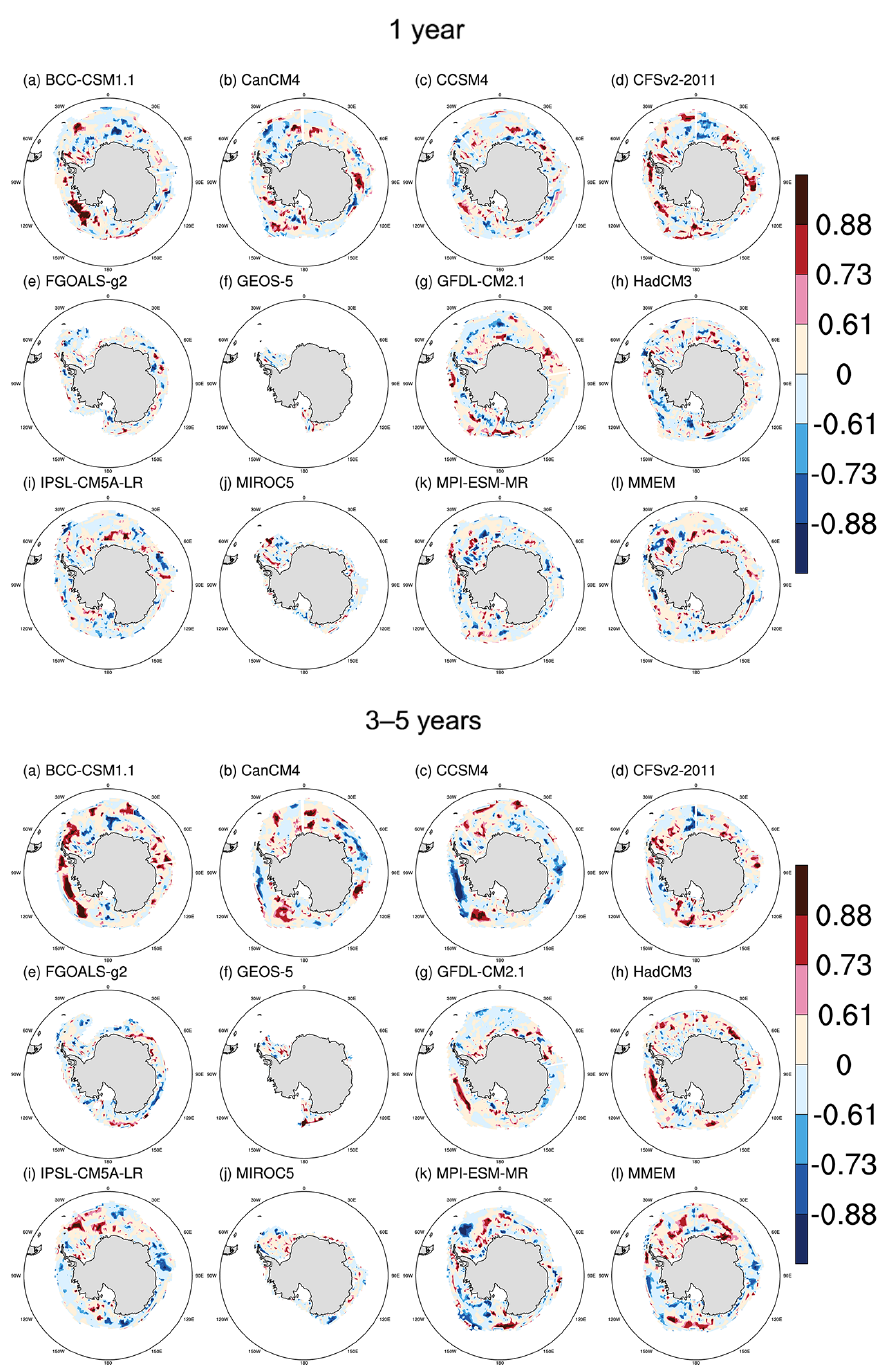
Figure 10. Same as Fig. 8, but for detrended September sea ice concentration anomalies.